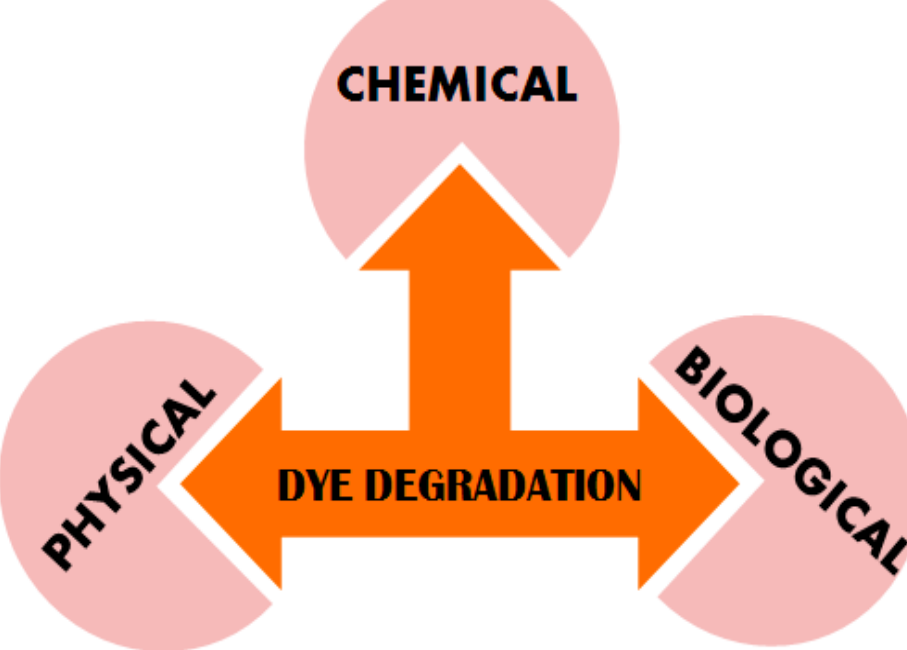
Figure 1. Different ways of dye degradation constitute the Physical, Chemical and Biological approaches.